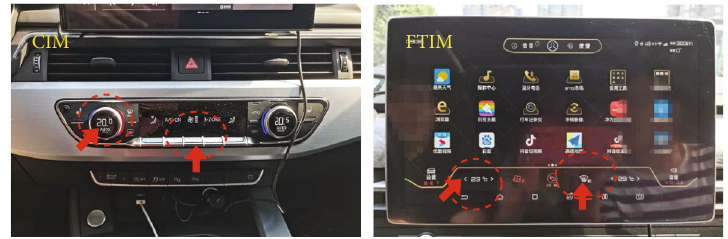
Figure 1: Two types of interaction modes.